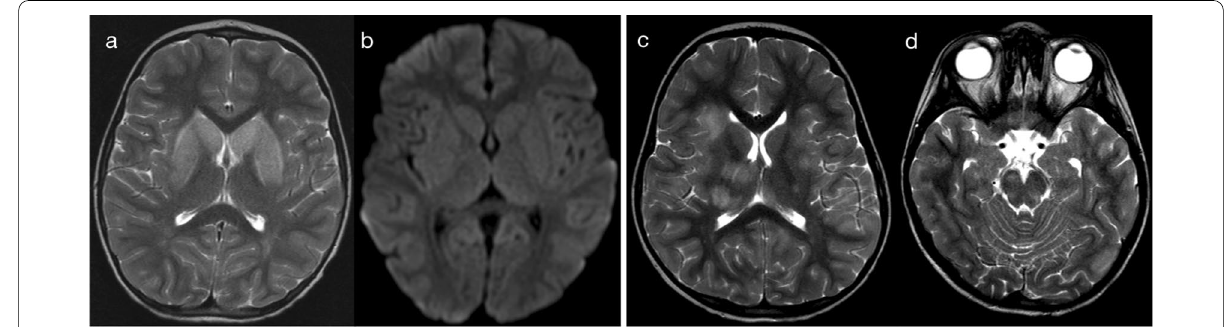
Fig. 14 T2 hyperintensity in basal ganglia and/or thalami (Pattern 5). Case 1: 5‑year‑old child with afebrile generalised tonic–clonic seizures and CSF‑proven EBV encephalitis. T2‑weighted imaging ( a ) demonstrated bilateral hyperintensity of the basal ganglia, without abnormality on DWI ( b ). Case 2: 4‑year‑old child with fever, sore throat, irritability and CSF‑proven EBV encephalitis. T2‑weighted imaging ( c , d ) demonstrated bilateral hyperintensity of the basal ganglia and thalami ( c ), as well as scattered lesions in the cerebrum and brainstem ( d ). No DWI abnormality was present (not